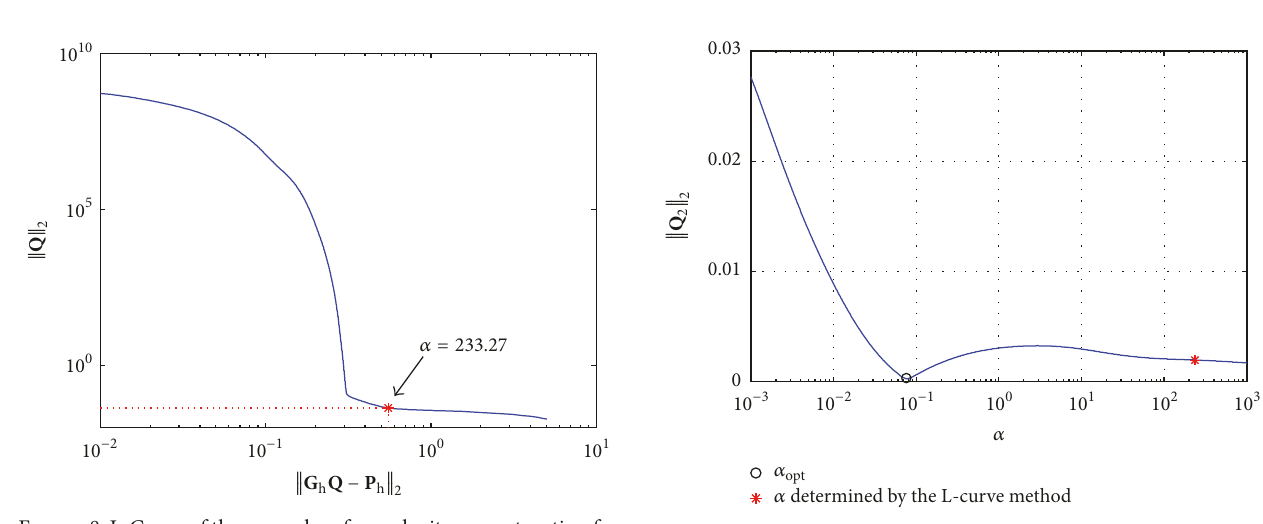
Figure 9: Object function versus the regularization parameter of the normal surface velocity reconstruction for the vibrating plate at 600